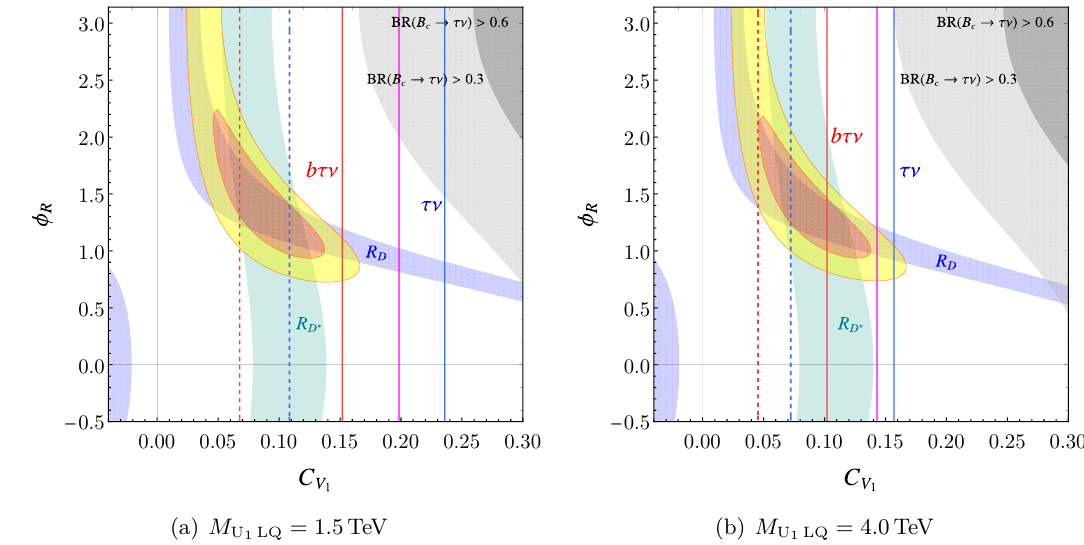
Figure 6 . The U(2) -U 1 scenario with M LQ = 1 . 5 and 4 . 0 TeV on the ( C V convention is the same as in figure 2. The magenta lines correspond to the current bound from the R L dt experimental data with = 36 fb − 1 by assuming M LQ = 2 TeV (left panel) and the EFT limit (right panel)